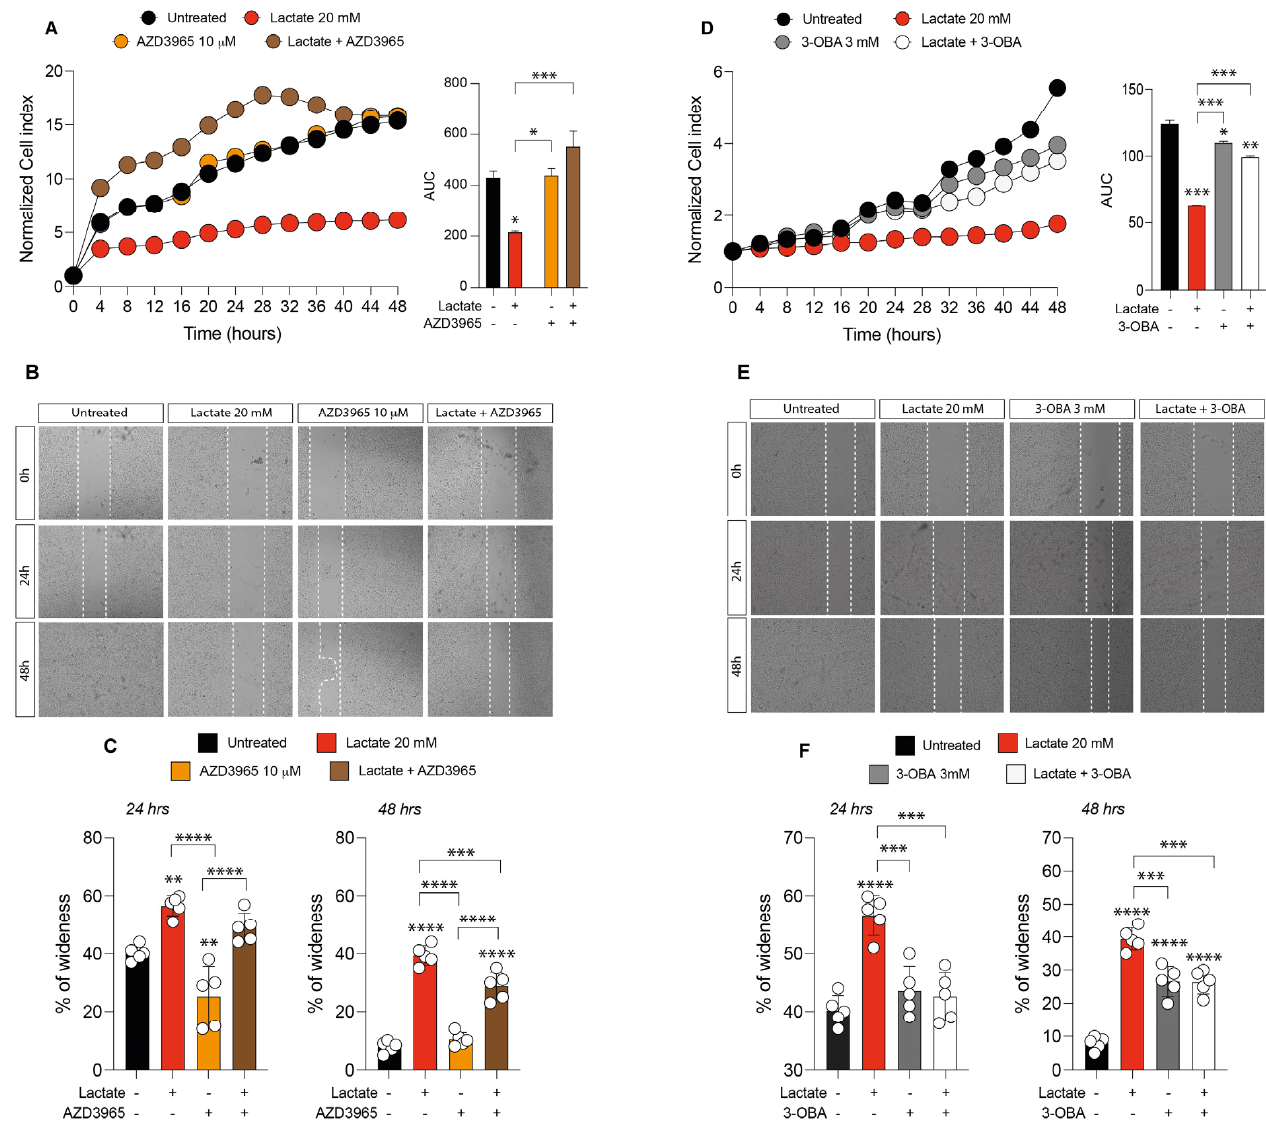
Figure 2. Effect of AZD3965 and 3-hydroxy-butyrate acid (3-OBA) on uveal melanoma cell proliferation and migration. ( A ) Real-time cell proliferation monitoring in 92.1 cells, using the xCELLigence system following treatments with lactate (20 mM) and AZD3965 (10 μ M); the cell index values were normalized at the time of pharmacological treatments in order to obtain a normalized cell index. Each dot expresses the average of four different experiments. ( B , C ) Representative micrograph ( B ) and quantification ( C ) of human uveal melanoma cell migration analysis with the wound-healing assay following treatments with lactate (20 mM) and AZD3965 (10 μ M). Data are mean of three independent experiments ± SD. ( D ) Real-time cell proliferation monitoring in 92.1 cells, using the xCELLigence system following treatments with lactate (20 mM) and 3-OBA (3 mM); the cell index values were normalized at the time of pharmacological treatments in order to obtain a normalized cell index. Each dot expresses the average of four different experiments. ( E , F ) Representative micrograph ( E ) and quantification ( F ) of human uveal melanoma cell migration analysis with the wound-healing assay following treatments with lactate (20 mM) and 3-OBA (3 mM). Data are mean of five independent experiments ± SD (two-way ANOVA). * p < 0.05; ** p < 0.01; *** p < 0.001; **** p < 0.0001.